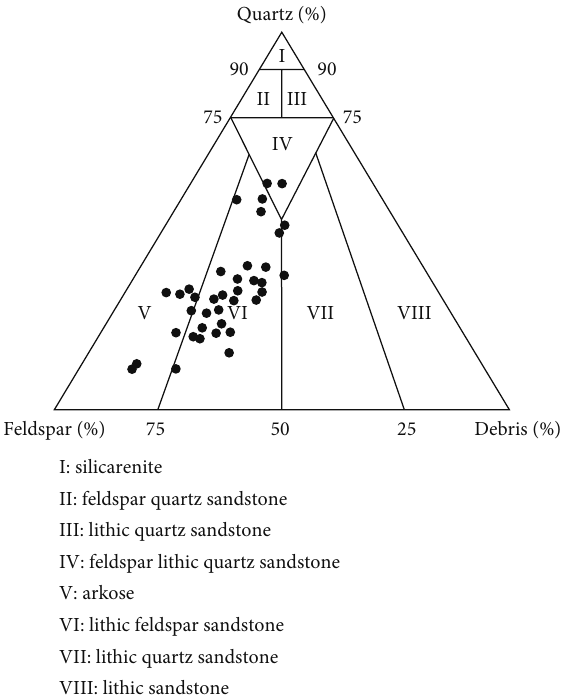
Figure 2: Rock type diagram of the Yan 9 32